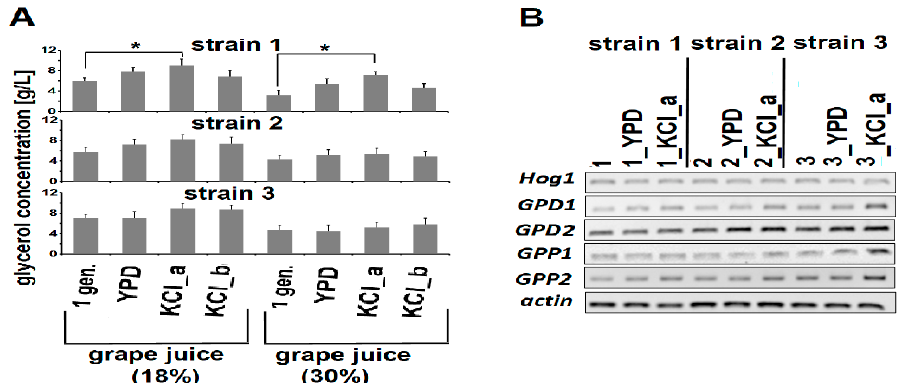
Figure 3. ( A ) Concentrations of glycerol [g / L] after the end of fermentation. Grape juice containing 18% sugars (10.2 g / L glucose and 7.7 g / L fructose) or 30% sugars (15.82 g / L glucose; 13.55 g / L fructose) were used as fermentation media. Data are presented as the means ± SD; n = 3. Significant di ff erences are marked by * (at p < 0.05). 1 gen. –1st generation (ancestral strains); YPD–YPD-evolved